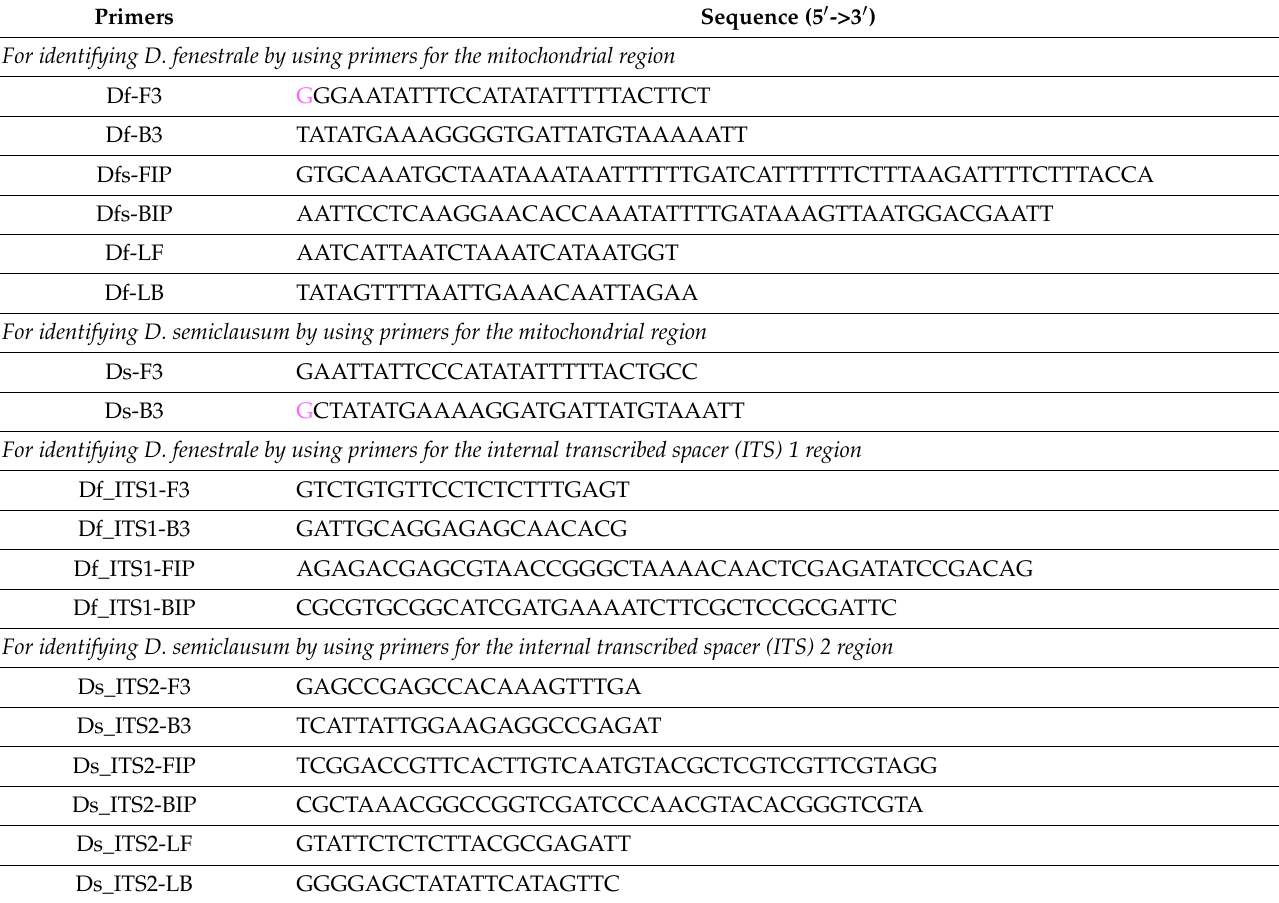
Table 1. Primers used in this study for the identification of the two Diadegma parasitoid species by LAMP and